Question: Give a one-sentence summary of this figure.
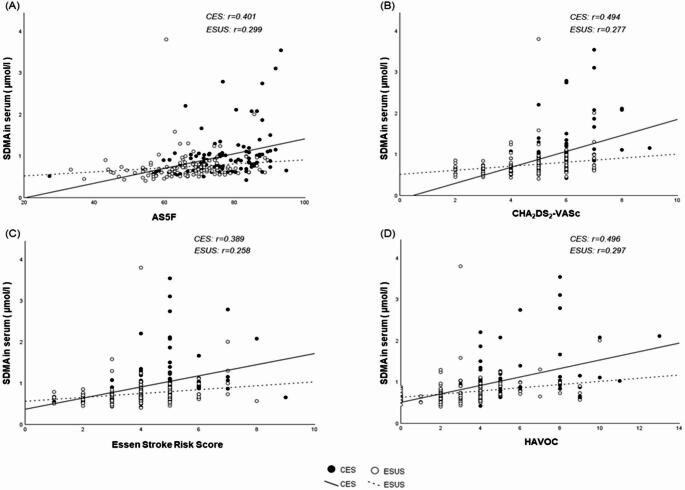
Answer: Correlation of SDMA with AF-scores in CES and ESUS: ( A ) AS5F, ( B ) CHA₂DS₂-VASc, ( C ) Essen Stroke Risk Score and ( D ) HAVOC